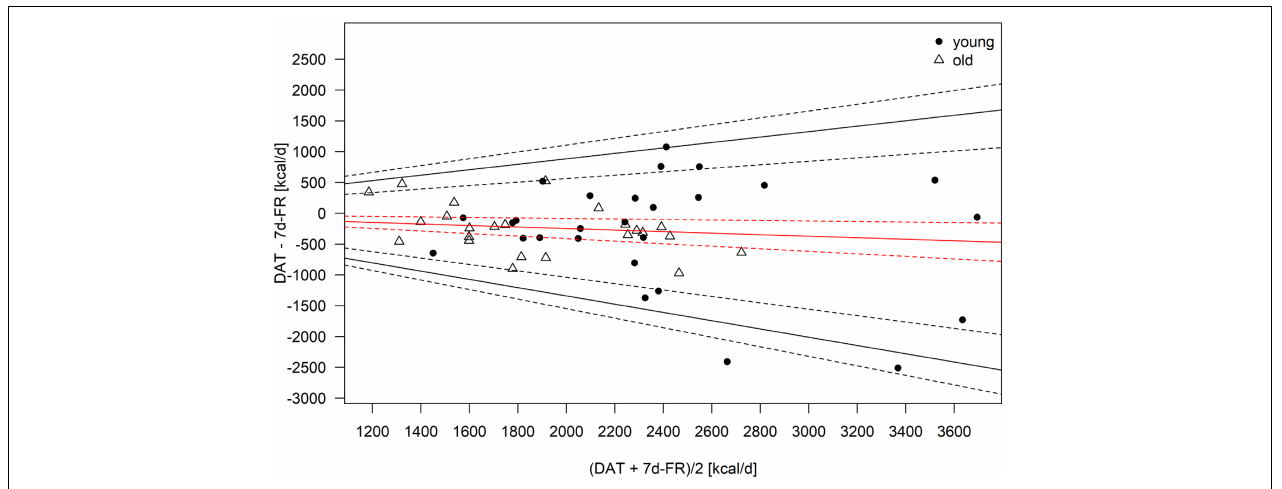
FIGURE 1 | Bland–Altman Plot of the total calorie intake as calculated from the 7-day food record (7 d-FR) and the visually aided dietary assessment tool (DAT). Legend: Red solid line, mean; black solid lines, 95% limits of agreement; dotted lines, 95% of the respective solid